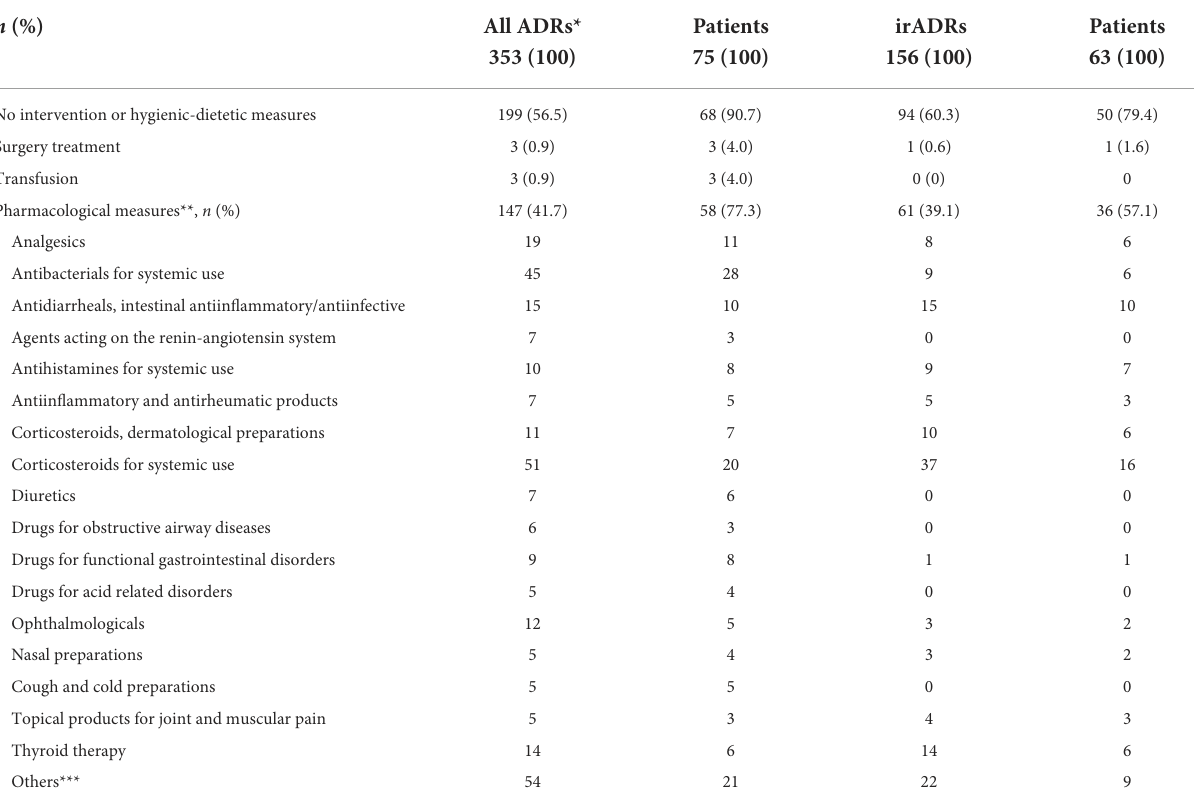
TABLE 5 Management of adverse drug reactions. n (%) All